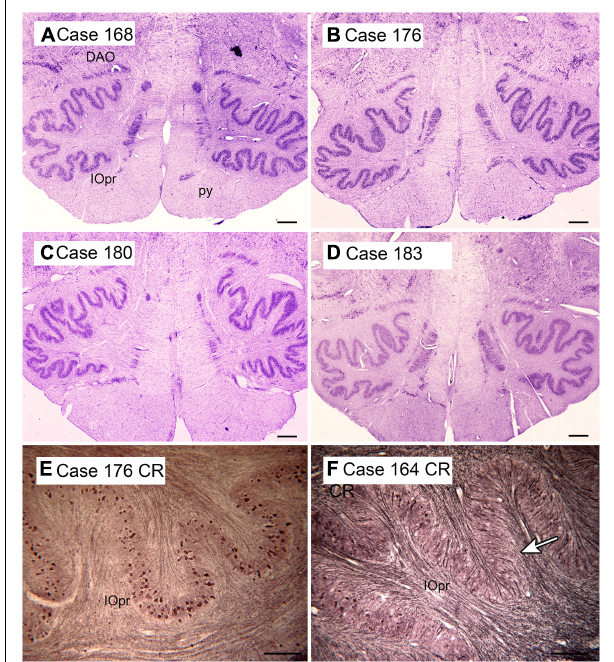
FIGURE 2 | Variability in the shape of the IOpr in humans. (A–D) The IOpr in cresyl violet stained transverse sections of the brainstem in four cases. Note the differences in the folding pattern among cases and the left-right asymmetry in each case. Scale bars = 1 mm. (E,F) Variability in the density of neurons expressing the calcium-binding protein calretinin (CR) illustrated in two cases. The arrow in (F) shows a region with few immunostained neurons. Scale bars = 250 µ m. CR, calretinin; DAO, dorsal accessory olive; IOpr, principal nucleus of the inferior olive. Figures 2 , 3 , 6 , and 8 show photomicrographs of sections that were prepared for several different projects on the human brainstem. Details of the methods are given in earlier publications (Baizer and Broussard, 2010; Baizer et al., 2011a,b, 2014, 2018a,b,